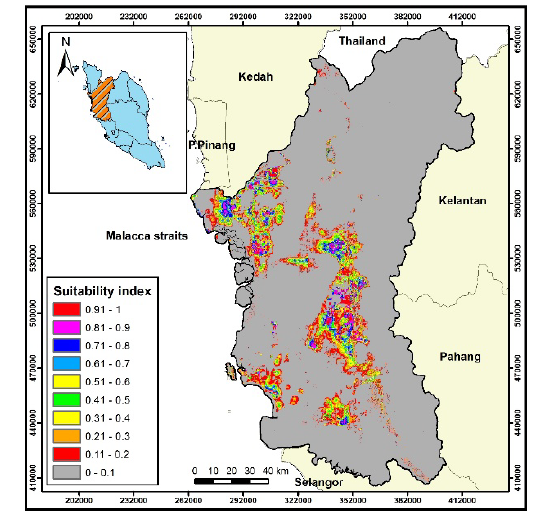
Figure 8. Landfill suitability